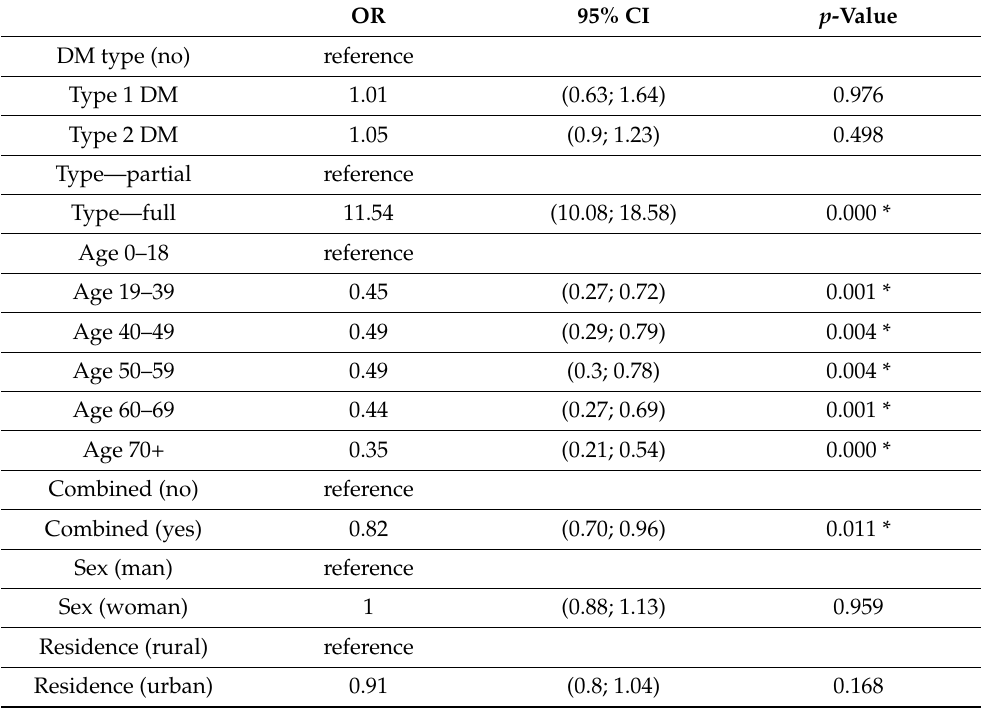
Table 5. A logistic regression model evaluating the factors correlated with urgent vs. elective CT in Poland during 2013–2017.